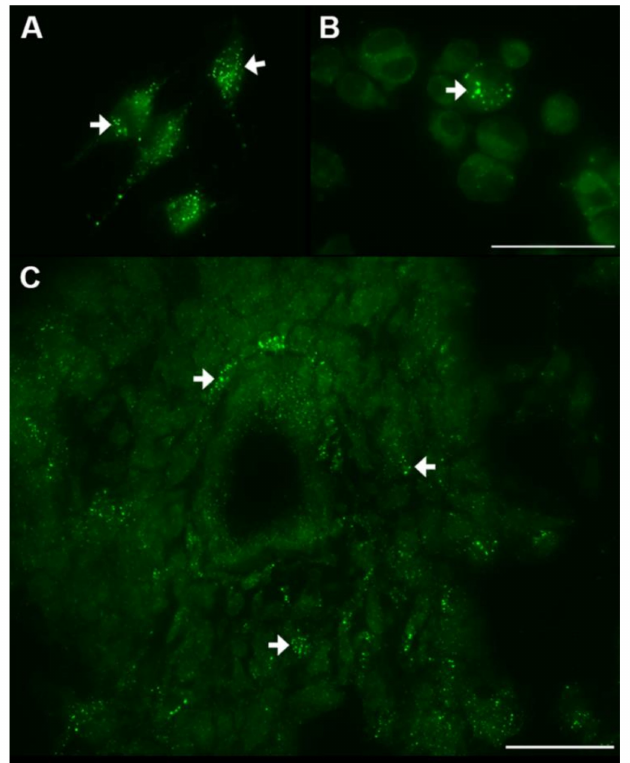
Figure 6. Intracellular activity of cathepsin B in lysosomal-like organelles (strongly green fluorescent dots, white arrows) in cultured differentiated glioblastoma cells (U373) ( A ) and GSCs ( B ) and in GSCs around an arteriole in a cryostat section of a patient-derived glioblastoma tumor ( C ). Localization of cathepsin B activity was performed as described in [83]. Bars, 50 µ